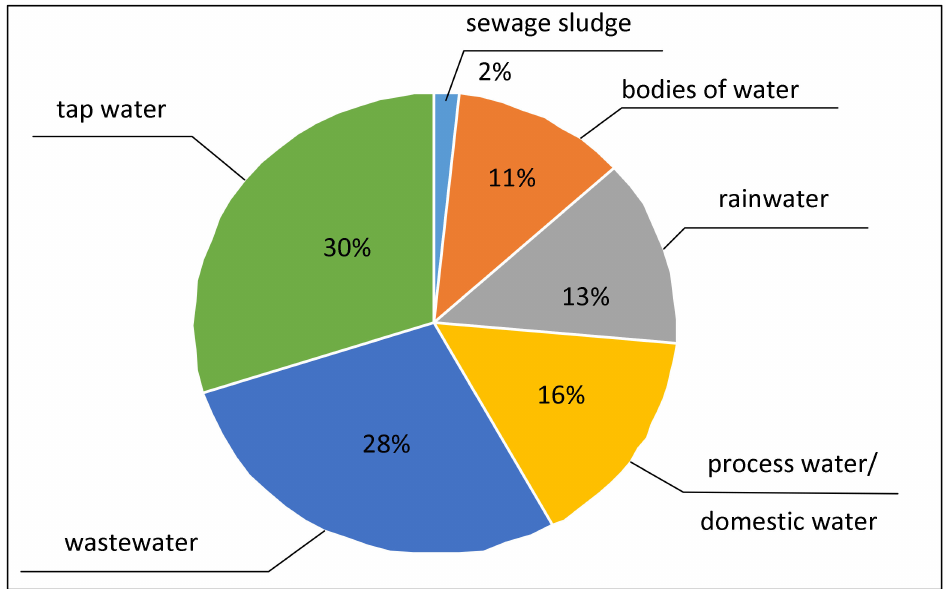
Figure 4. Application areas of identified digitization elements ( n = 698).